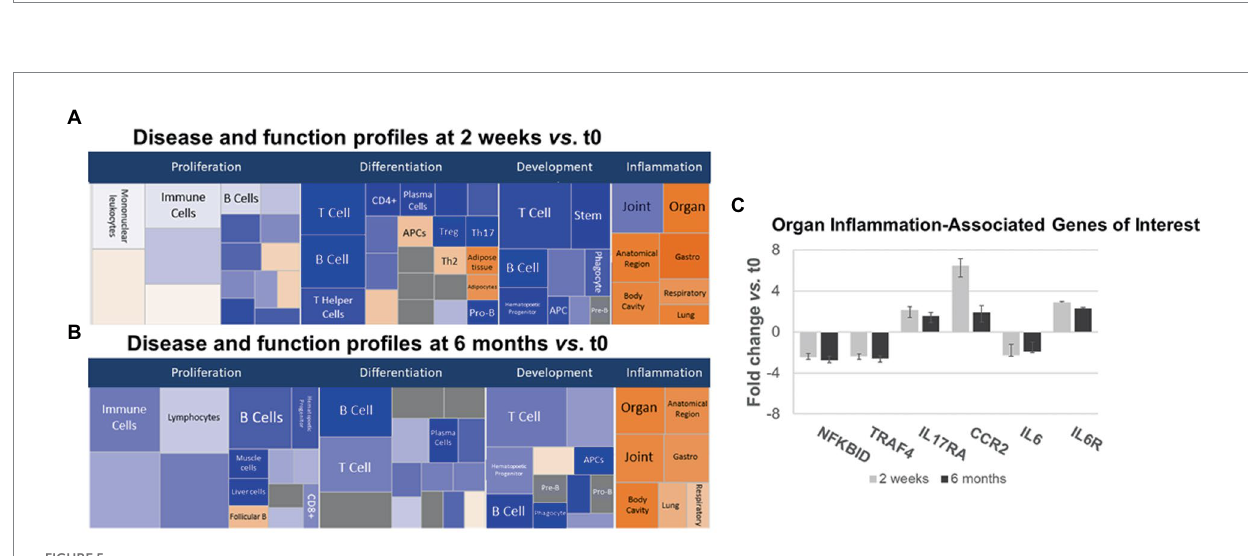
FIGURE 5 Ingenuity pathways analysis (IPA) disease and function pathways classification of immune-relevant effects of ocrelizumab in MS PBMC. Disease and Function analysis of gene expression in MS PBMC at 2 weeks (A) and 6 months (B) after infusion vs. t0. There is downregulation of B- and T-cell proliferation, differentiation, and development pathways, but upregulated inflammatory pathways. Klimt plot squares are sized by significance ( − log10[value of p of fold-change]) and colored by z -score of the expression magnitude of predicted inhibition (blue) or activation (orange). (C) Organ- specific or region-specific inflammatory gene expression in PBMC from MS patients at 2 weeks and 6 months after ocrelizumab infusion compared to time 0. All are fold-change > |1.5|. Genes triggering the pro-inflammatory “organ-specific” result in (A,B) include upregulated pro-inflammatory IL6R , IL17RA , and CCR2 , and downregulated anti-inflammatory NFKBID and TRAF4